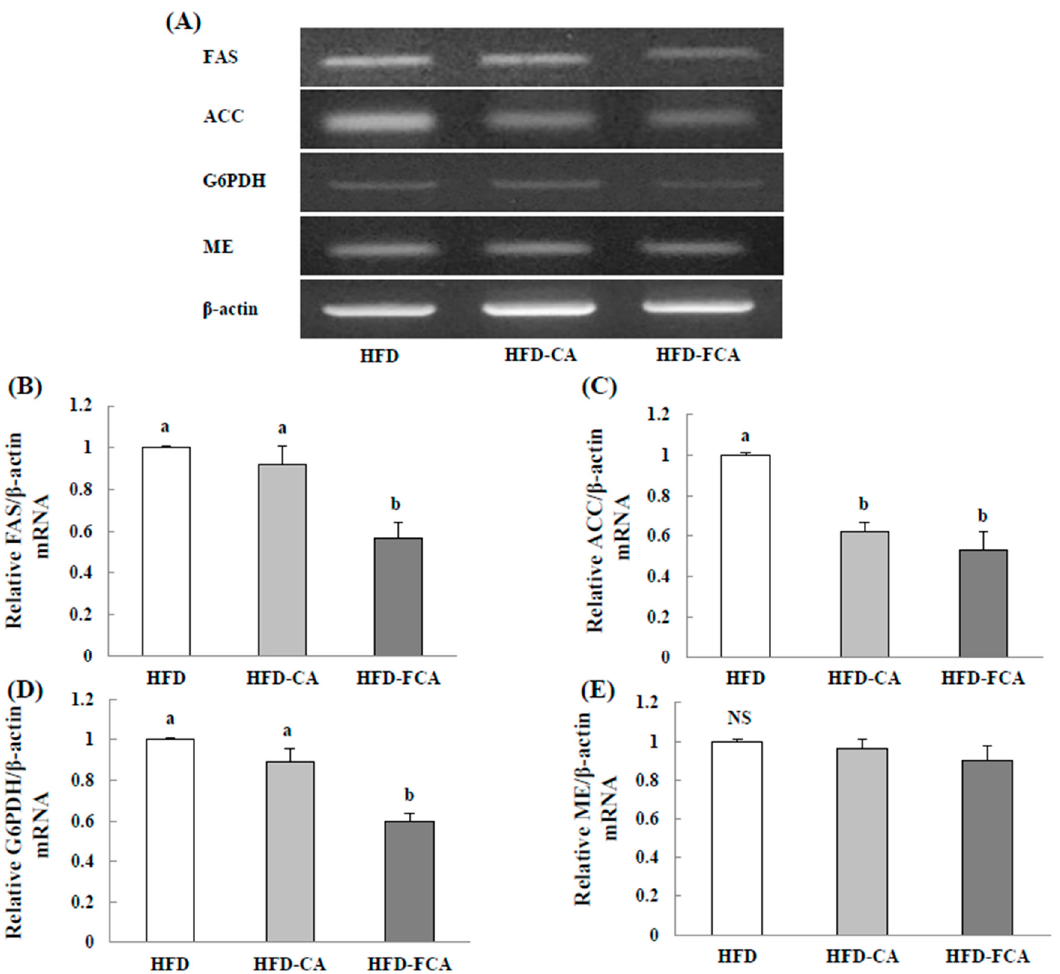
Figure 5. mRNA expression levels of enzymes related to lipid synthesis ( A ) in livers of rats fed experimental diets for eight weeks. The mRNA expression levels of FAS ( B ), ACC ( C ), G6PDH ( D ), and malic enzyme (ME) ( E ) were measured by RT-PCR. In the determination of mRNA levels, β -actin served as a loading control. Values are mean ± SE ( n = 8 rats per group). a,b; Bars with different letters are significantly different at p < 0.05 by Tukey’s test. Diet groups; HFD, high fat diet group: HFD-CA, HFD + cabbage-apple juice administration group: HFD-FCA, HFD + fermented cabbage-apple juice administration group.